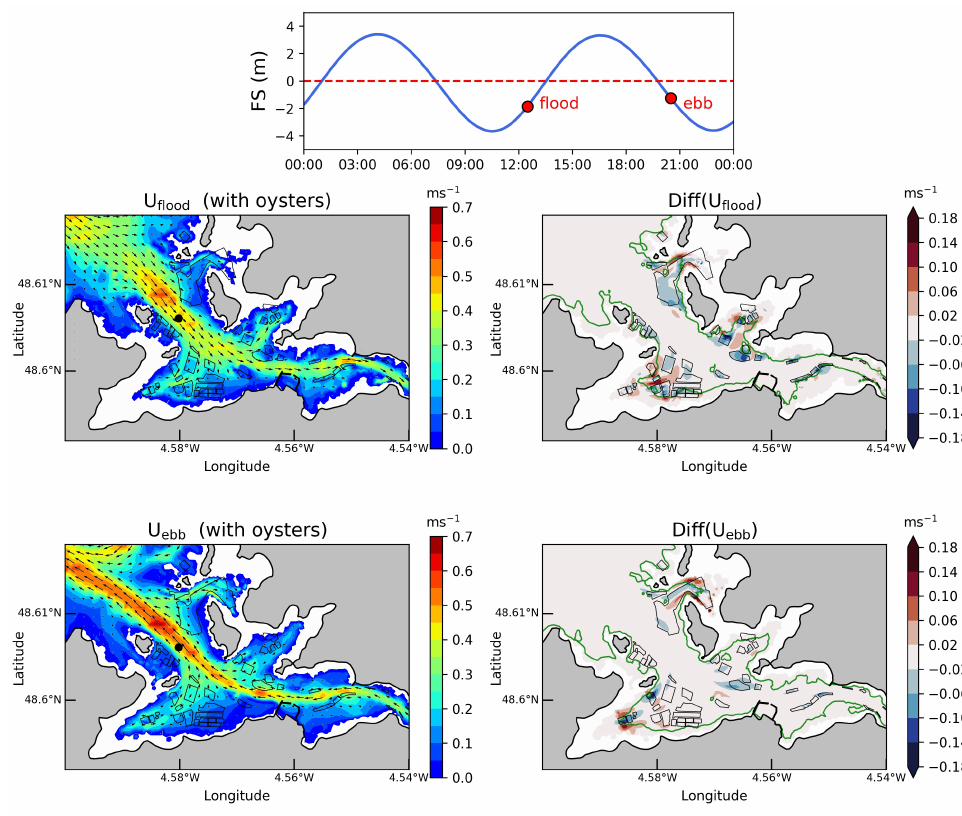
Figure 11. ( left ) Depth-averaged currents during peak flood and ebb of a mean spring tide in configuration E 3 . ( right ) Differences in current magnitudes between simulations with (E 3 ) and without (E 1 ) the effects of oyster tables. Positive values account for an increase in current magnitude with oyster tables, while negative values exhibit a decrease in current magnitude. Top figure shows the time series of the free-surface elevation (with respect to mean water depth) in the access channel to the estuary (the location is indicated with a black circle on left figures). Time steps retained for the extraction of synoptic predictions are displayed with red circles on top figure. Black lines delimit the extents of oyster farming elevated structures, while green lines correspond to a total water depth of 0.8 m, the height of the upper side of oyster